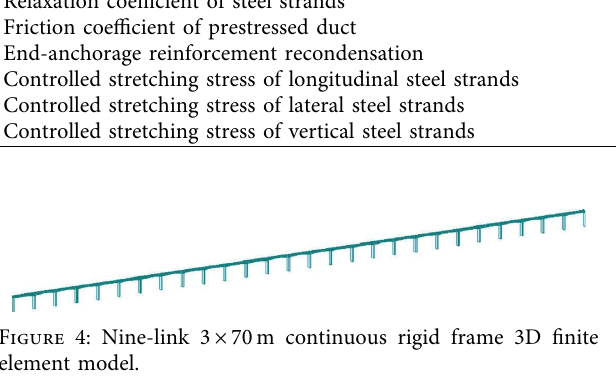
Figure 5: Vertical deformation diagram of the maximum cantilever state.